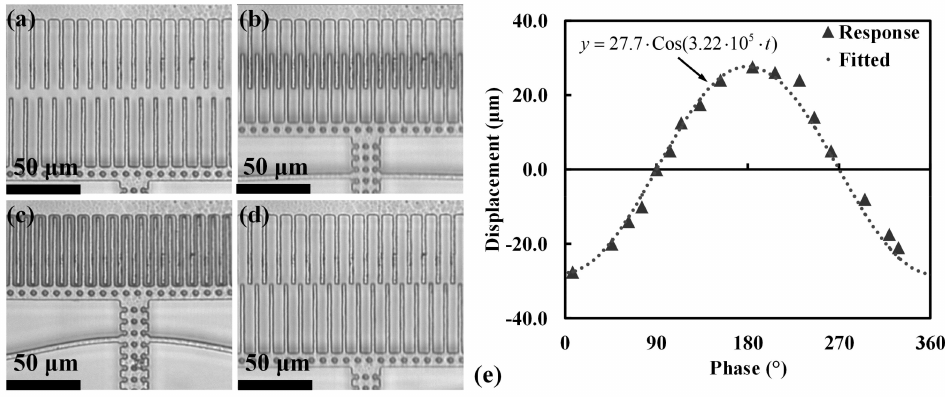
Figure 11. Phase resolved resonant motion of a test comb drive actuator imaged through stroboscopic imaging system at resonance at ( a ) 7 ◦ , ( b ) 90 ◦ , ( c ) 184 ◦ , ( d ) 330 ◦ , and ( e ) graph of displacement vs. phase w.r.t. the drive pulse shows a cosine relation between displacement and time, which is consistent with the device theory in discussed in Section